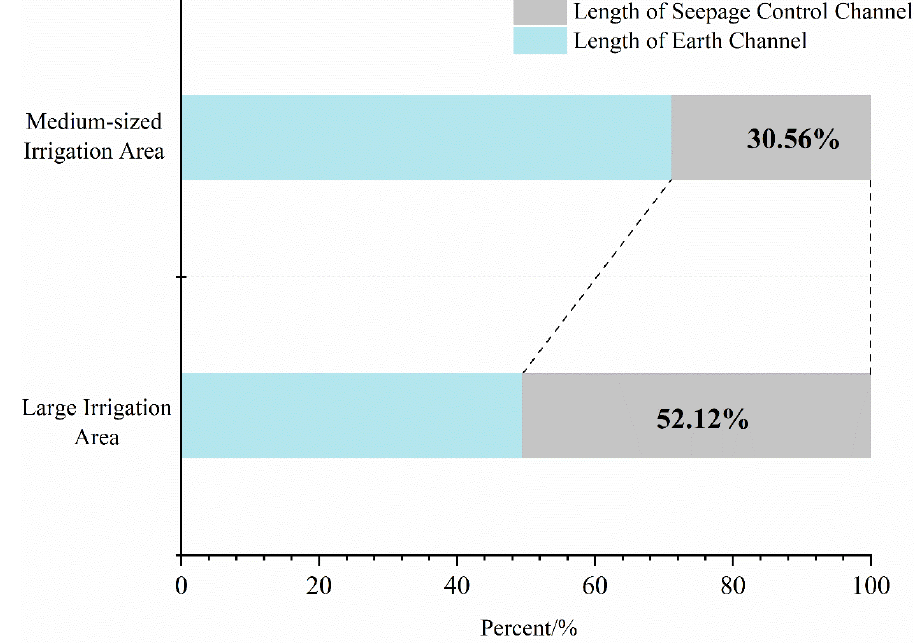
Figure 11. Canal seepage prevention ratios of for large- and medium-scaled irrigation areas.